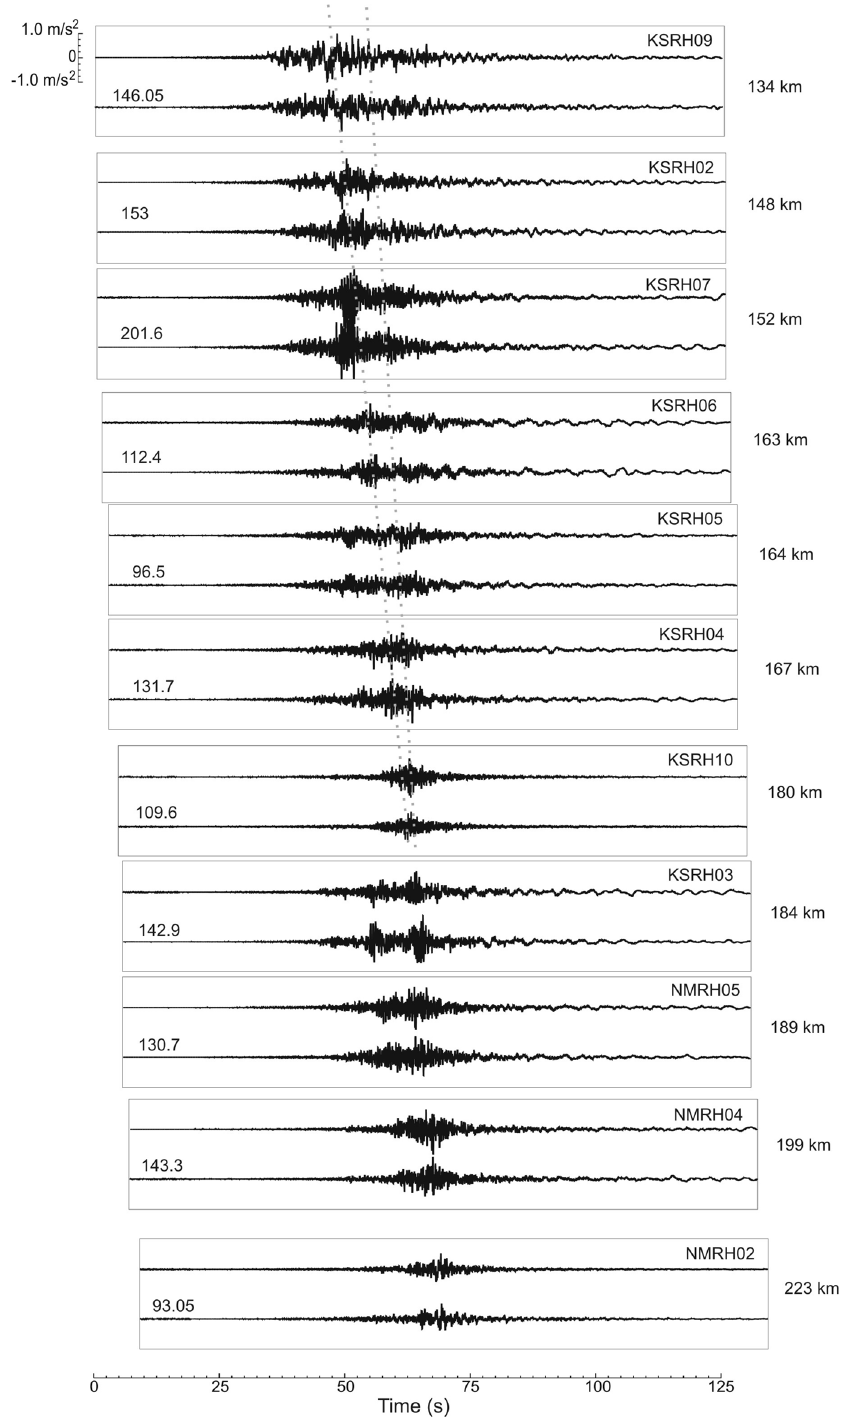
Figure 4. Acceleration time histories (EW and NS components, depth records) of the Tokachi-oki earthquake at KiK-net sites located to the north of the epicenter. For each site, the epicentral distances (on the right) and PGA in cm/s2 (on the left) are shown. Dotted lines show the decrease of the duration of strong motion with